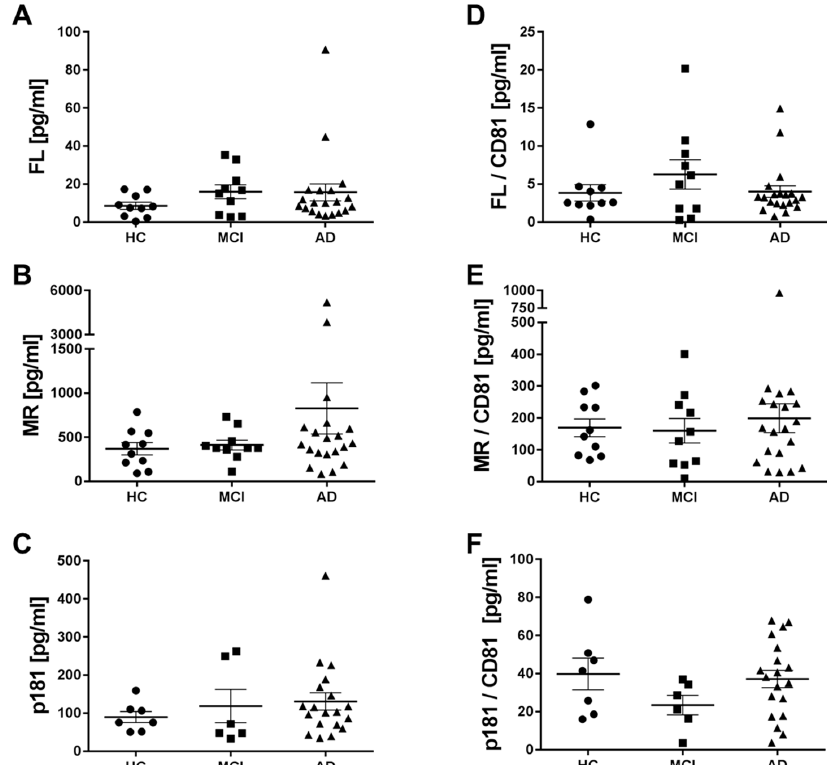
Figure 7. Levels of different types of tau in neuronal exosomes from healthy controls, AD and MCI subjects. ( A – C ) When full-length (FL), mid-region (MR), and ptau-181 (p181) results were stratified